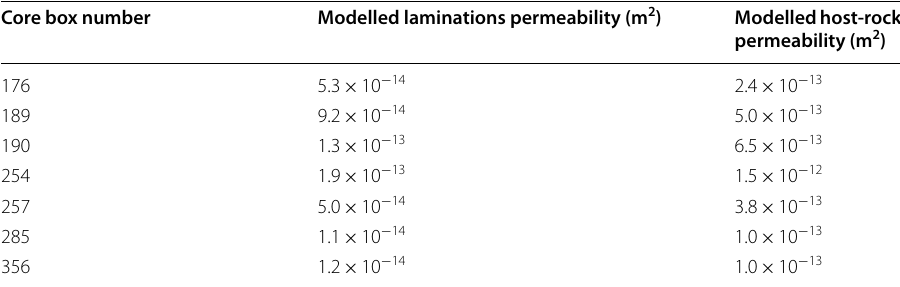
Table 2 Modelled permeabilities for the laminations and host-rock from each of the seven Buntsandstein cores investigated in this study using a model for the permeability of monodisperse granular media (Wadsworth et al. 2016). See text for details